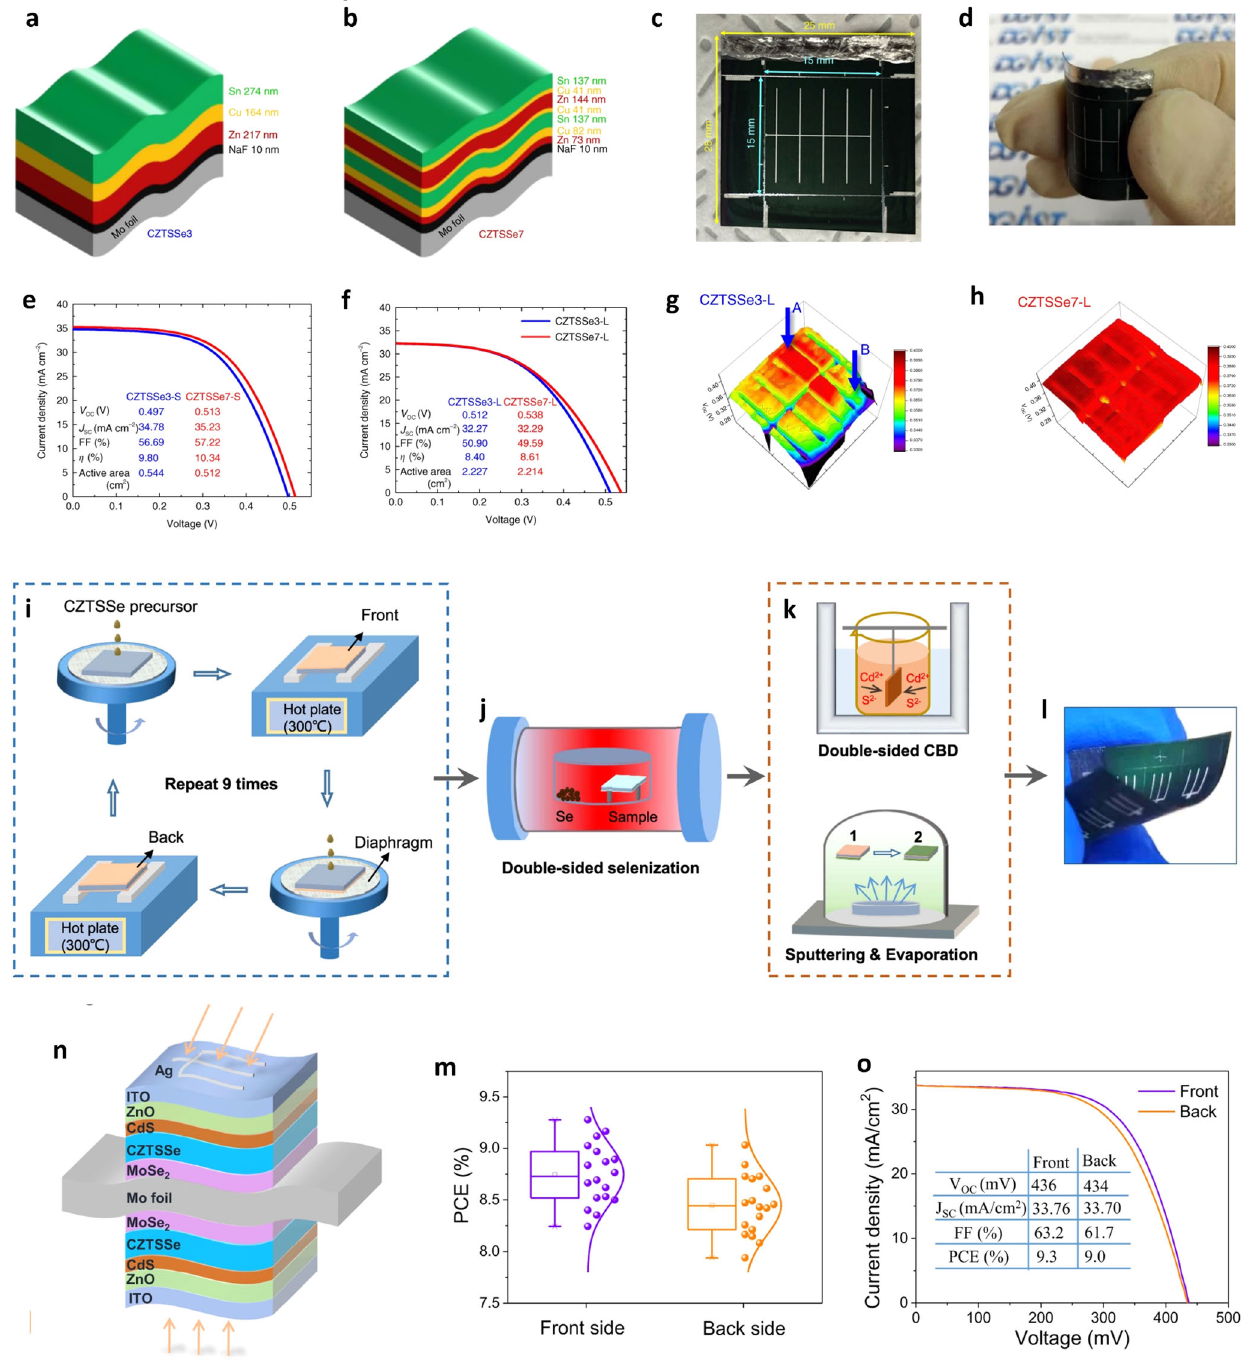
Fig. 2 Representative fl exible CZTSSe thin- fi lm solar cells fabricated on Mo foils. a , b 3-layer and 7-layer stacking structures respectively of the sputtered metal precursors on Mo foil substrates. c , d photos of a fl exible CZTSSe cell with size of ~15 mm × 15 mm on a Mo foil substrate, fabricated by DGIST group. e , f Current – voltage curves of small area (~0.5 cm 2 ) and large area (~2.2 cm 2 ) fl exible CZTSSe solar cells fabricated with 3-layer stacking precursor and 7-layer stacking precursor respectively. g , h Within-cell uniformity of Voc measured by micro current- voltage for 2.2 cm 2 cells fabricated with 3-layer stacking precursor and 7-layer staking precursor respectively. Reproduced with permission 71 . i – l Fabrication processes of solution-based bifacial fl exible CZTSSe thin fi lm solar cells on Mo foil substrates, developed by the Fuzhou University group. n Schematic diagram of the device structure of the bifacial fl exible CZTSSe thin fi lm solar cells. m Front and back side ef fi ciencies of the bifacial CZTSSe thin- fi lm solar cells. o Current density – voltage curves of the front cell and back cell of a representative bifacial CZTSSe cell. Reproduced with permission 72